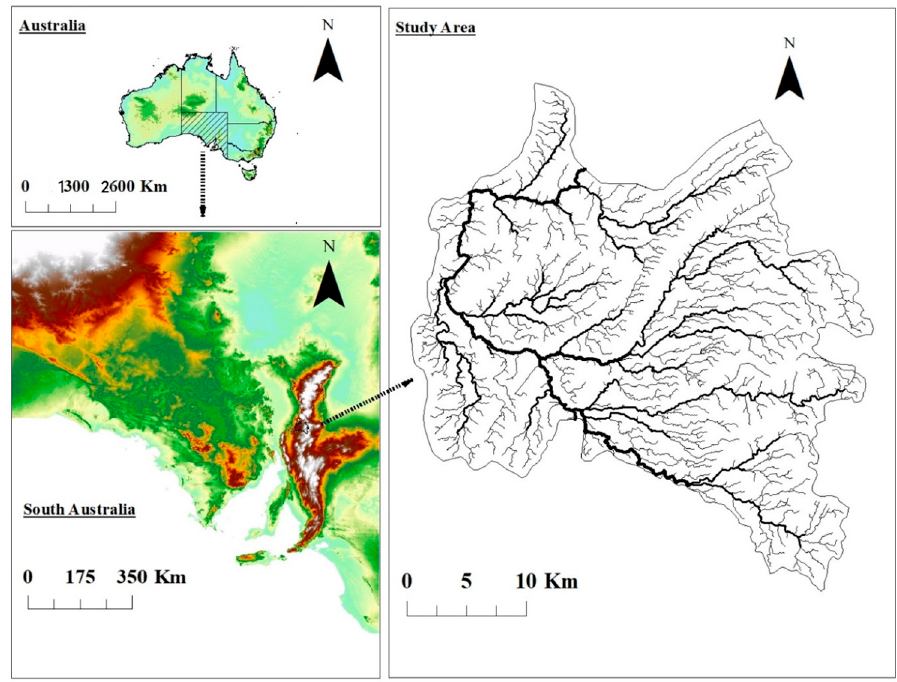
Figure 1. Location of the study area showing the wells’ locations in the Hawker Area.